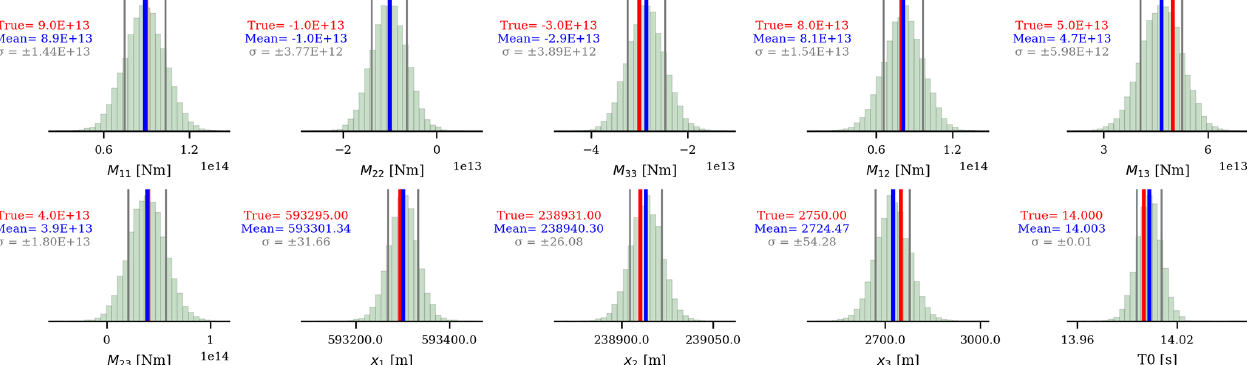
Figure 12. Marginal posterior distributions for each model parameter given the selected chains (depicted as green dots in Fig. 10). The blue lines represent the means, and the standard deviations are represented by the gray lines. The red lines represent the true